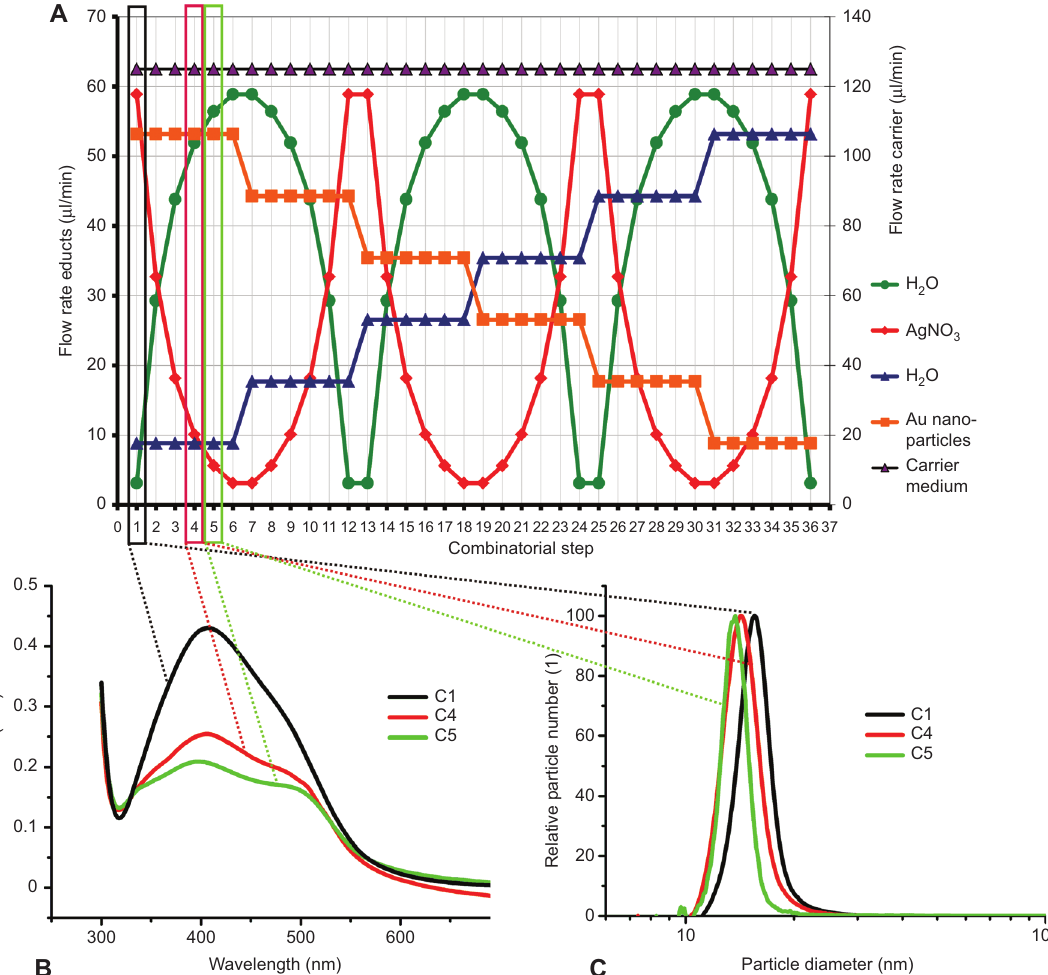
Figure 8 (A) Programmed flow rate course for the combinatorial synthesis of Au/Ag core/shell nanoparticles in microfluid segments.